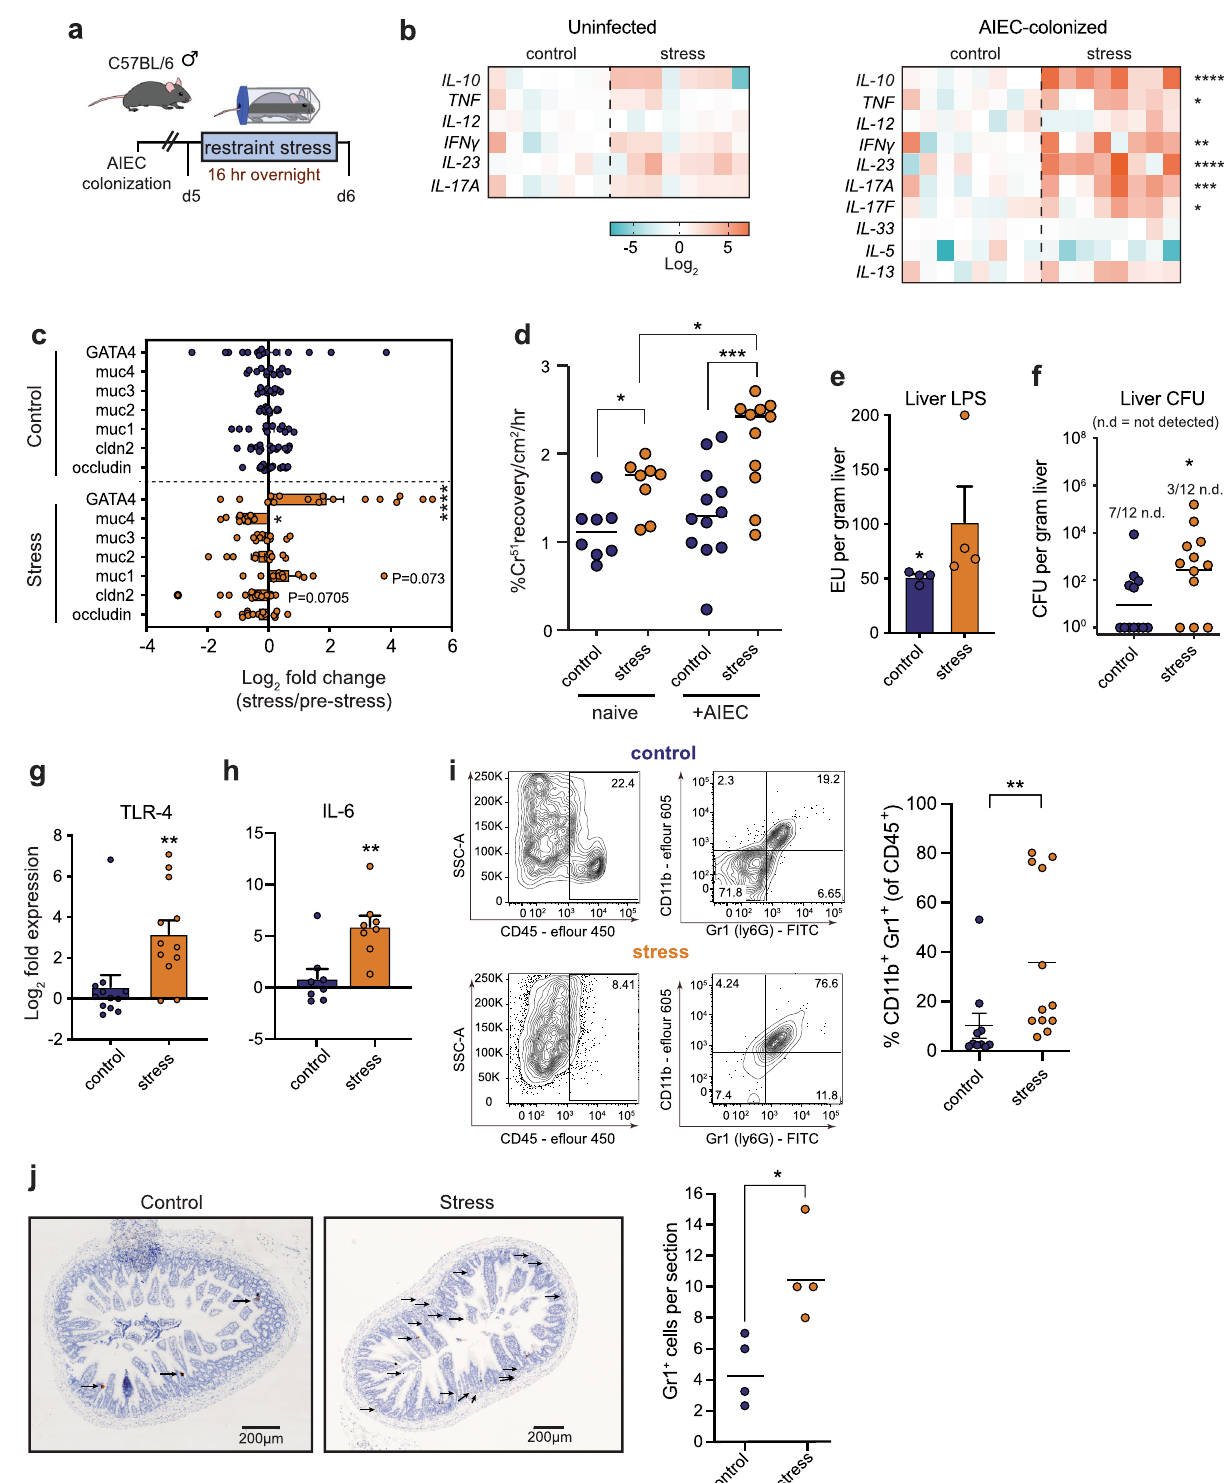
(Supplementary Fig. 2). Indeed, fl ow cytometry revealed that stress induced a marked recruitment of CD45 + CD11b + Gr1 + immune cells to the ileum, a cell population consistent with neutrophils (Fig. 3i). An increase in GR1 + cells in the tissue was con fi rmed by immunohistochemistry (Fig. 3j). Together, these fi ndings indicated that stress induces a profound impairment of intestinal barrier function with an attendant in fl ammatory response that is exacerbated in the presence of